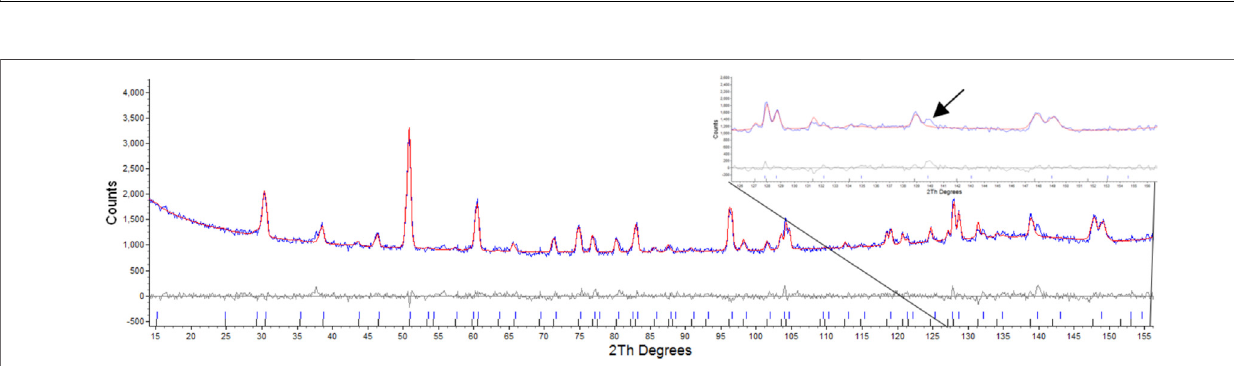
Frontiers in Chemistry |